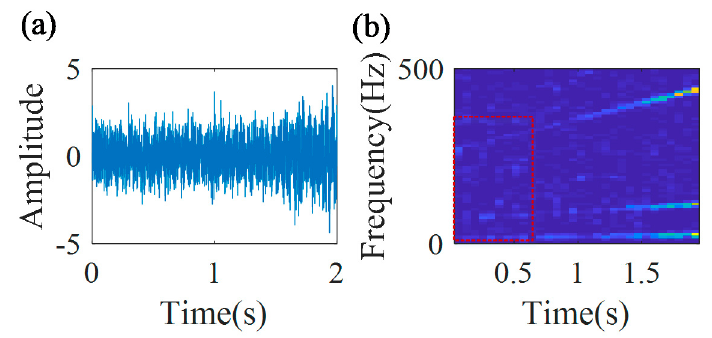
Figure 10. ( a ) Multi-component signal; and ( b ) its TFR.